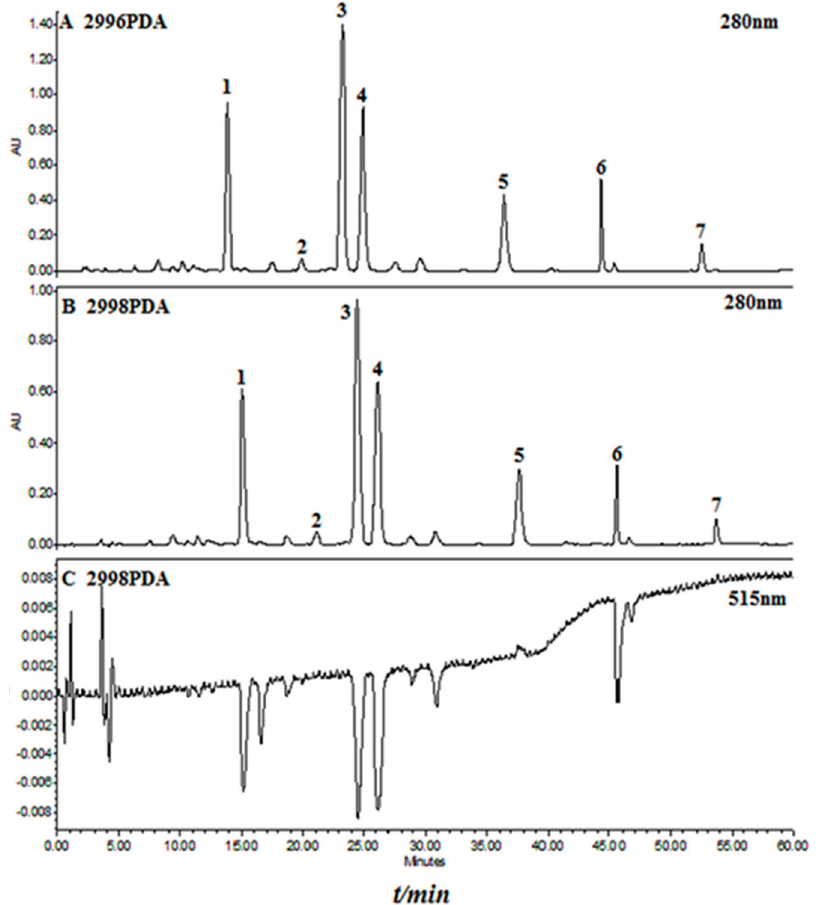
Figure 2. Liquid chromatographic analysis of methanol extract of O. indicum ( A ), together with the online post-column DPPH chromatogram ( C ) depicted as negative peaks. Four major active compounds were deduced by comparison of retention times with the chromatogram at 280 nm ( B ): ( 1 ) baicalein-7- O -gentiobioside; ( 2 ) chrysin-7- O -gentiobioside; ( 3 ) baicalein-7- O -glucoside; ( 4 ) baicalin; ( 5 ) chrysin-7- O -glucuronide; ( 6 ) baicalein; ( 7 )